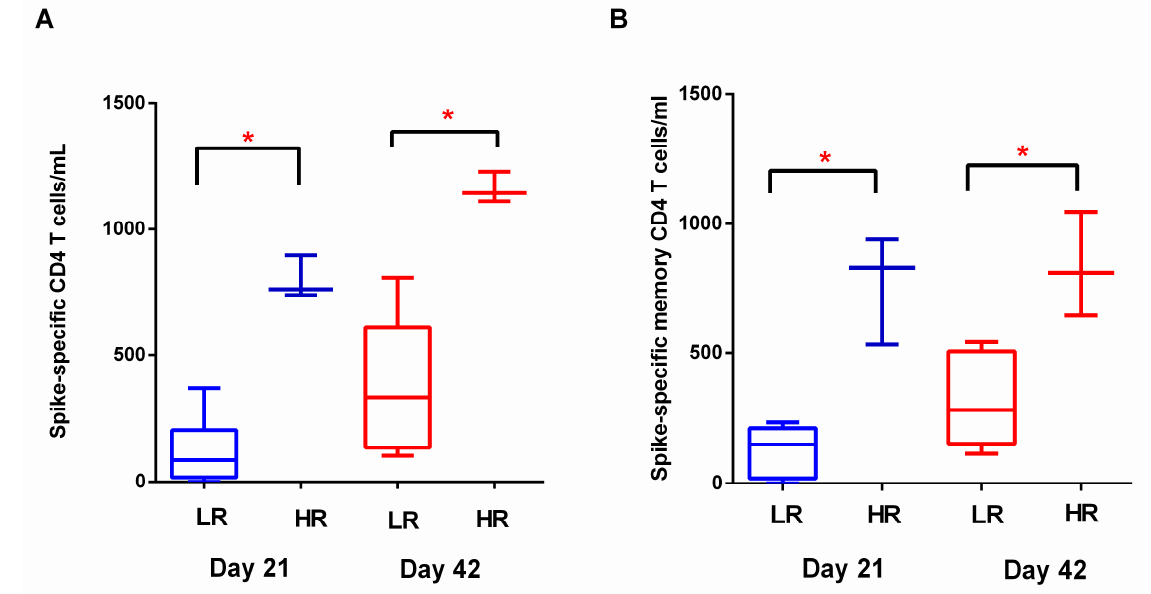
Figure 6. Humoral response after the first BNT162b2 dose may reflect the magnitude of cellular immunity. High responders (HR) (RBD-IgG > 50 AU/mL on D21) developed higher frequencies of ( A ) spike-specific CD4 T cells and ( B ) spike-specific memory CD4 T cells on either D21 or D42 com- pared to low responders. (LR). Data are represented as median values (min to max). * : p -value<0.05